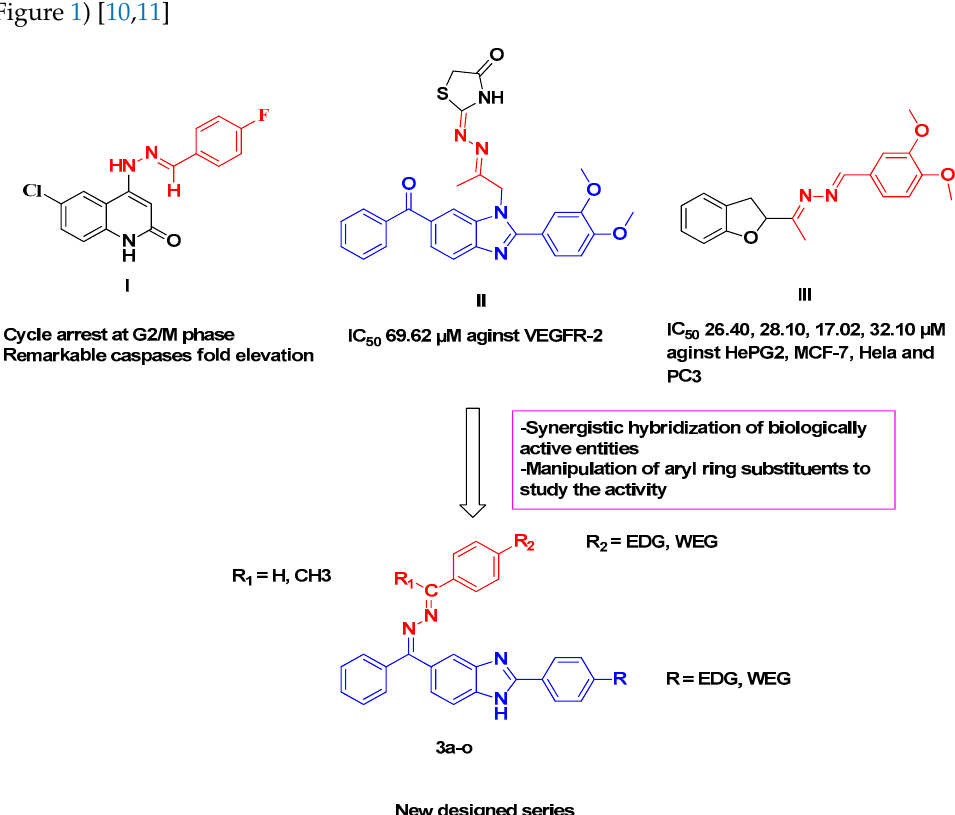
Figure 1. Rational design of the new hybrid target compounds.